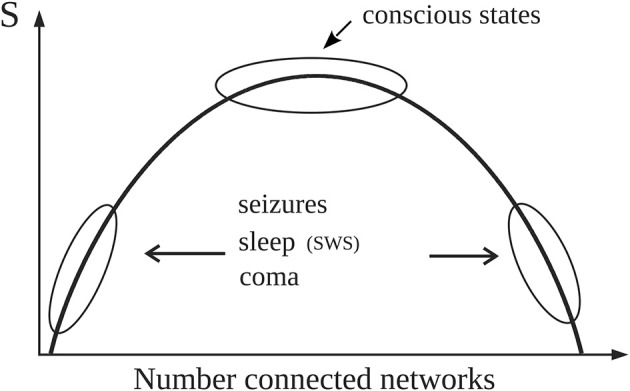
Simple schematic depicting the main results reported in Guevara et al. (2016) that are used in the text (please see technical details in the original publication). Normal alertness resides at the top of the curve representing the entropy (S) associated with the number of configurations of connected brain cell networks. The top of the curve with high S represents large number of configurations (microstates) of network connections which provides the variability in brain activity needed for normal cognition. Pathological or unconscious states like slow wave sleep (SWS) are located away from the top, thus characterized by either large or small number of “connected” networks therefore exhibiting lower number of microstates, hence lower entropy. As detailed in the text, for constant noise (T) and energy (E), G will be then lower near the top of the curve because of the high values of S.